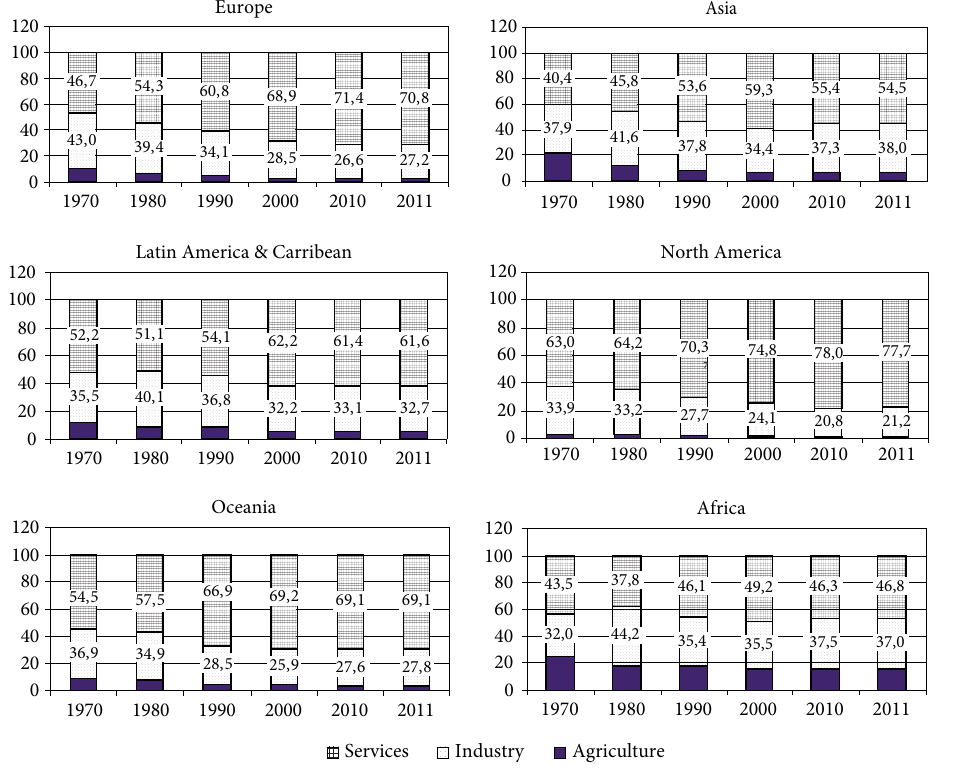
Fig. 2. Sectоr distributiоn оf tоtal value added by regiоn, in percent Sоurce: authоrs’ calculatiоns based оn the UN Statistics